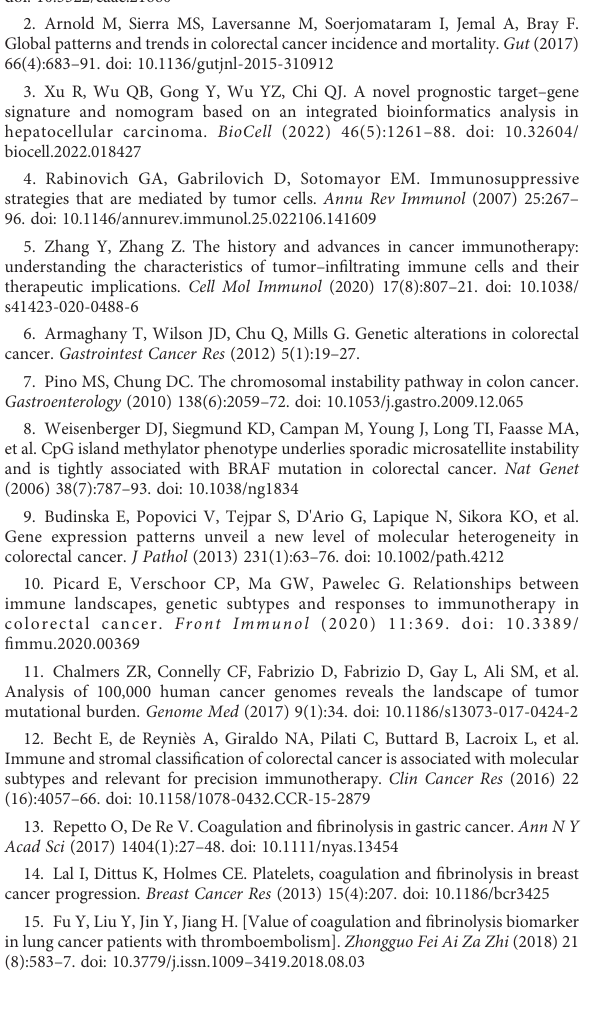
SUPPLEMENTARY FIGURE 1 The relationship of immune cell in fi ltration with CXCL8 level in THCA. (A) Overall survival analysis for CXCL8 in CRC patients was performed using the Kaplan – Meier plotter. (B) Survival-dependent receiver operating characteristic (ROC) curve validation of prognostic value of the prognostic index. (C) The correlation of CXCL8 expression level with immune score, stromal score, and ESTIMATE score. (D) Relationships among in fi ltration levels of 24 immune cell types and CXCL8 expression pro fi les by ssGSEA. (E) Correlation of CXCL8 expression with immune in fi ltration level in CRC. *p < 0.05, **p < 0.01, ***p <